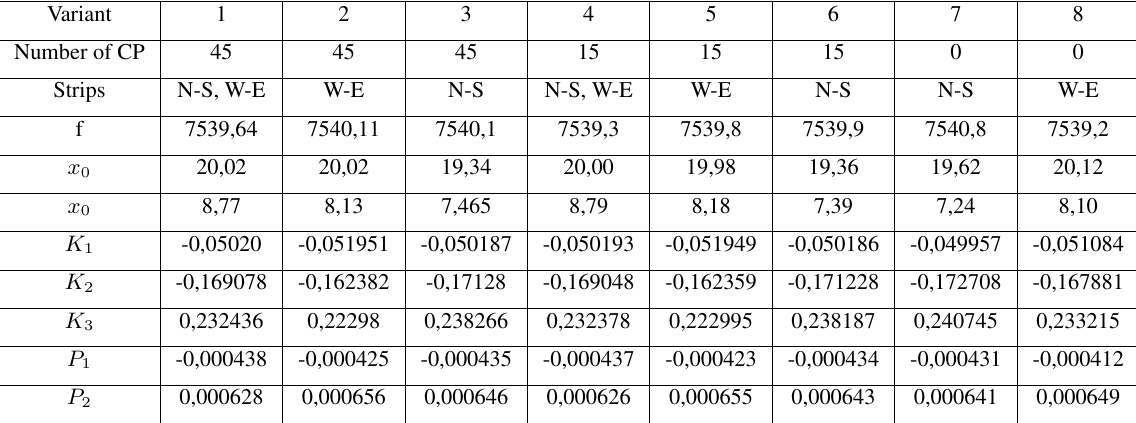
Table 2. Values of parameters of photogrammetric calibration in pixels.